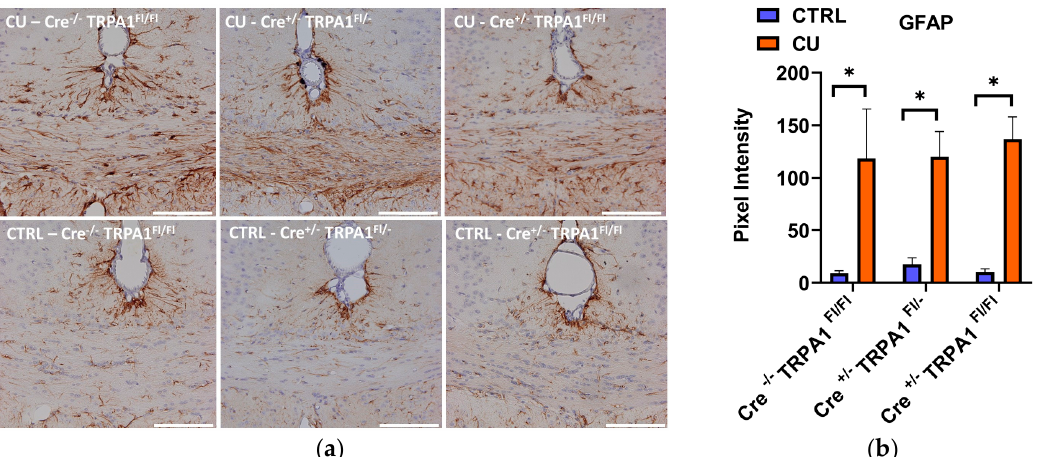
Figure 6. Evaluation of astrocyte activation by GFAP immunohistochemistry after 6 weeks of cuprizone treatment (a) Representative images of control (CTRL) and cuprizone-treated (CU) groups in GFAP-Cre − / − TRPA1 Fl/Fl , GFAP-Cre +/ − TRPA1 Fl/ − and GFAP-Cre +/ − TRPA1 Fl/Fl mice.; (b) Pixel intensities of diaminobenzidine staining in the middle part of the corpus callosum in each group; * p < 0.05, n = 3 – 5/group, Scale bar = 100 µm.